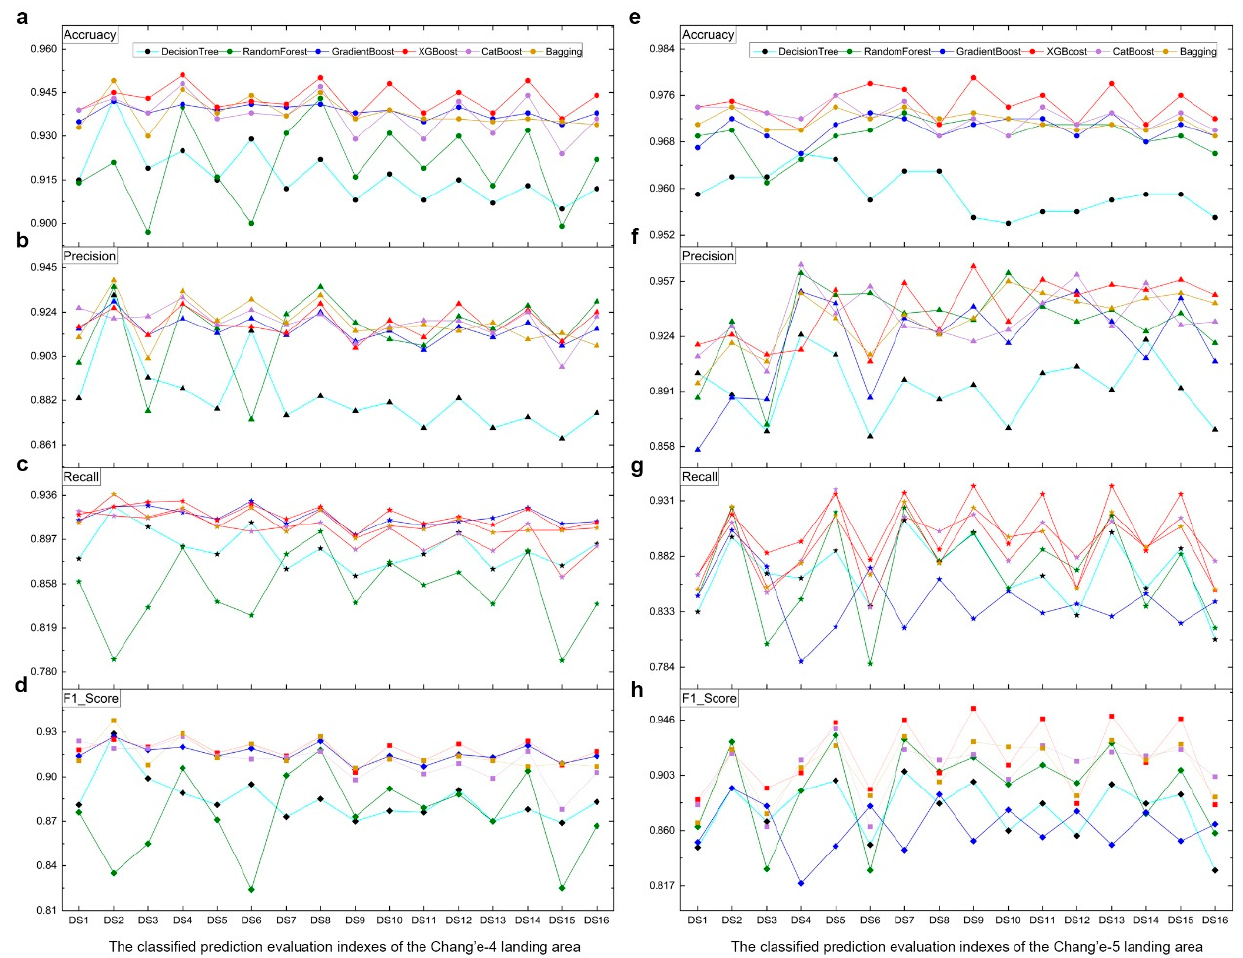
Figure 5. The summary of obtained accuracy, precision, recall and f1-score for each classification model of the two study areas. ( a – d ) The landing area of Chang’e-4, and ( e – h ) the landing area of Chang’e-5.